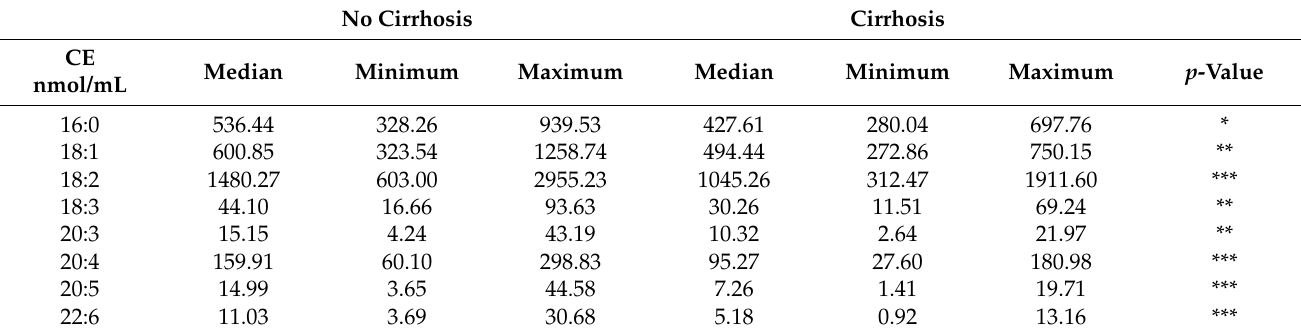
In the 29 patients with ultrasound-diagnosed liver cirrhosis, serum CE 16:0, 18:1, 18:2, 18:3, 20:3, 20:4, 20:5 and 22:6 were lower than in the patients without cirrhosis (Table 4). Table 4. CE levels in serum of patients without and with liver cirrhosis diagnosed by ultrasound at therapy end. Only species which significantly differed between the two groups are listed. * p < 0.05, ** p < 0.01, *** p < 0.001.